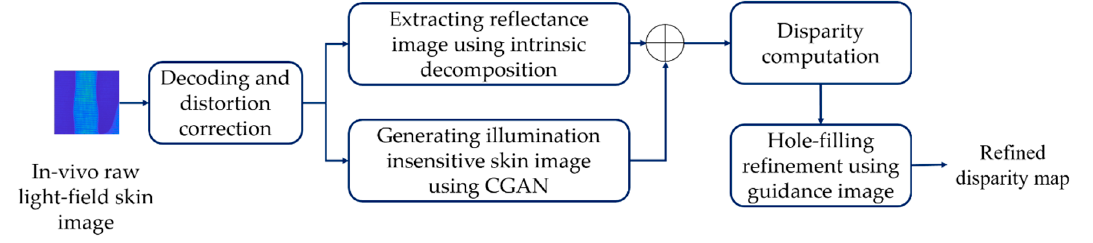
Figure 2. Overall flowchart of our proposed method.